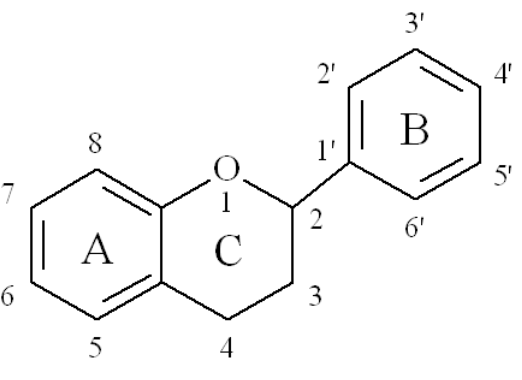
Figure 1. General chemical structure of flavonoids.